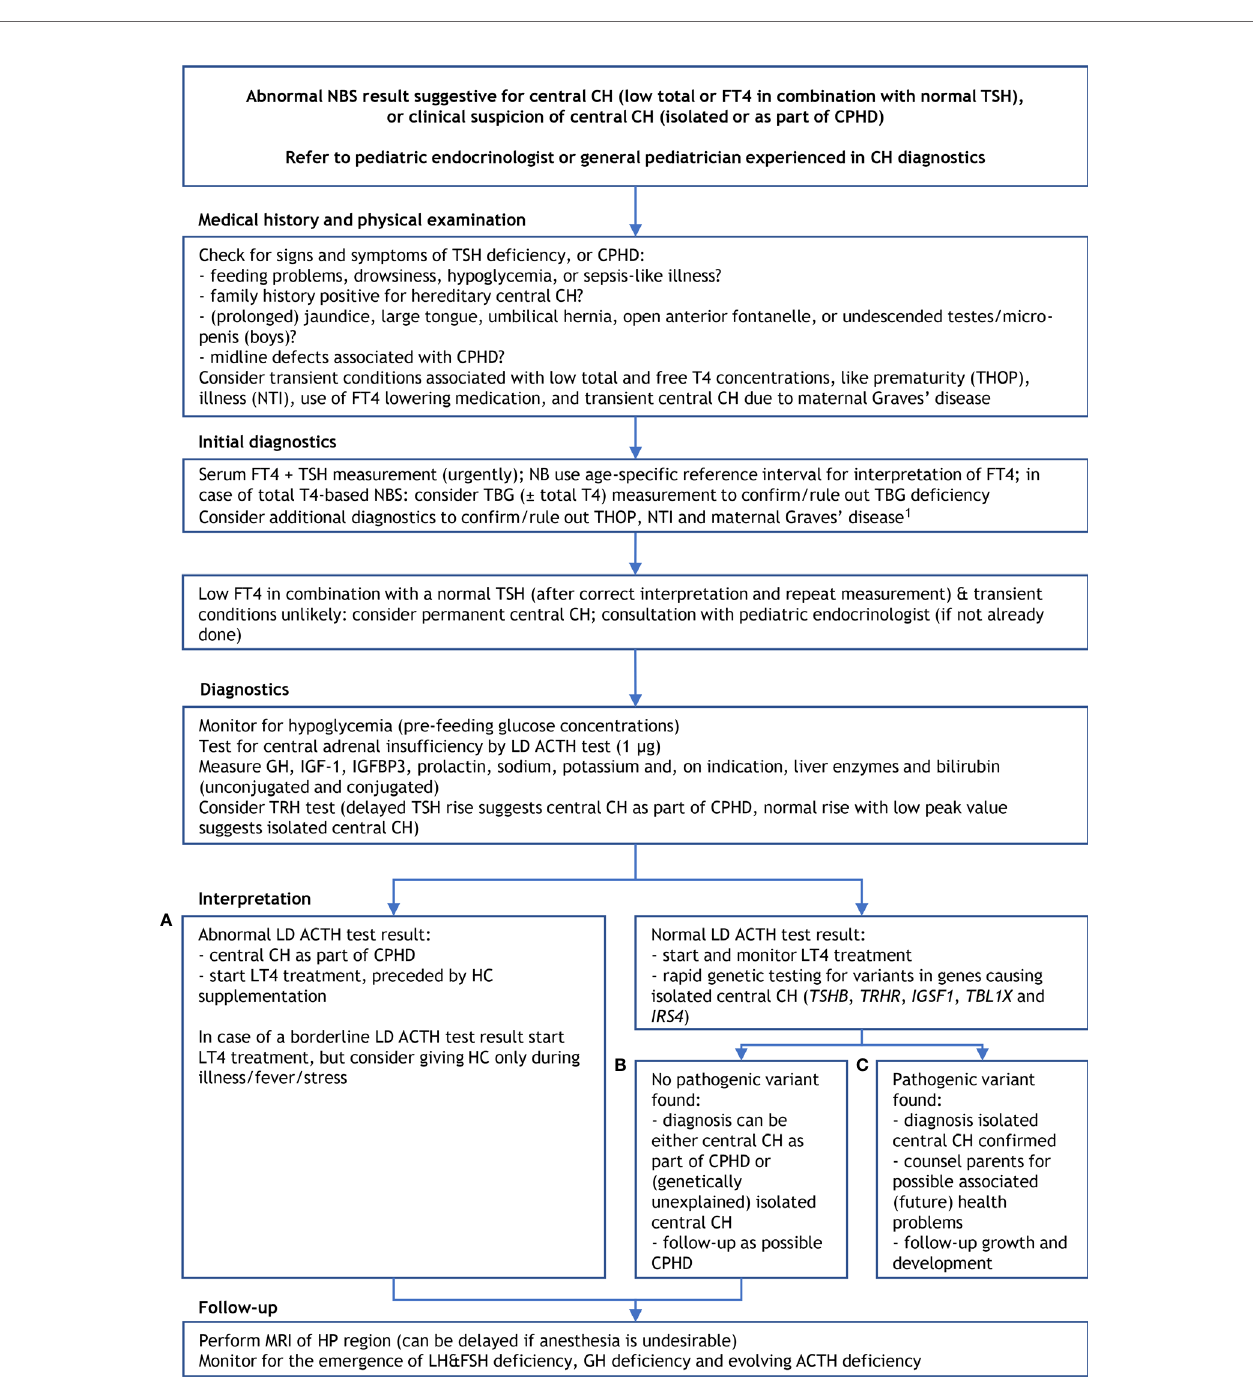
FIGURE 4 | Proposed diagnostics after an abnormal newborn screening result suggestive for central congenital hypothyroidism. 1 suspicion of THOP: re-measure FT4 and TSH at term age, suspicion of NTI: measure (F)T3 ± rT3, re-measure FT4 and TSH at recovery; suspicion of transient central CH due to maternal Graves ’ disease: measure TSHRAb and maternal thyroid function, and start thyroxine treatment when the newborn ’ s FT4 is too low. ACTH, adrenocorticotropic hormone; CH, congenital hypothyroidism; CPHD, combined pituitary hormone de fi ciency; FT4, free thyroxine; FSH, follicle stimulating hormone; GH, growth hormone; HC, hydrocortisone; HP, hypothalamic-pituitary; IGF-1, insulin-like growth factor 1; IGFBP3, insulin-like growth factor binding protein 3; LD, low dose; LH, luteinizing hormone; LT4, levothyroxine; MRI, magnetic resonance imaging; NBS, newborn screening; NTI, non-thyroidal illness; rT3, reverse triiodothyronine; T4, thyroxine; TBG, thyroxine binding globulin; TH, thyroid hormone; THOP, transient hypothyroxinemia of prematurity; TRH, thyrotropin releasing hormone; TSH, thyroid stimulating hormone; TSHRAb, TSH receptor antibodies. (A – C) refer to three scenarios of different outcomes of the work-up of central CH (see the Management